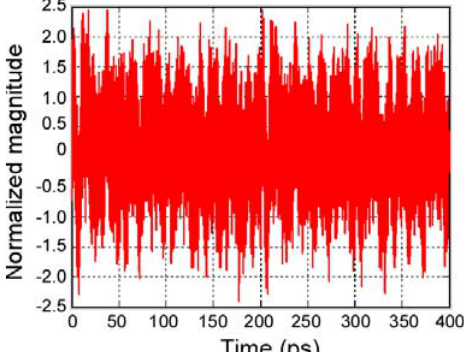
Figure 6. Received signals. It contains the both phase-encoded channel #1 and channel #2 signals plus the additive noise accumulated in the transmission. White noise with normal distribution is used as the additive noise in the simulation. The average value and the standard deviation of the normal noise are 0 and 0.5, respectively. The received signal is corrupted with interference from the other channel and the additive